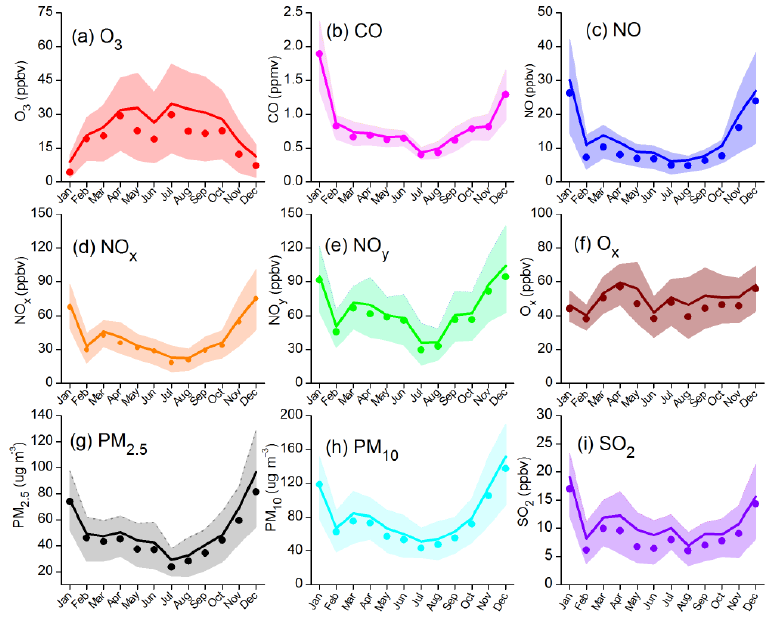
Figure 2. Seasonal variations of atmospheric O 3 (a) , CO (b) , NO (c) , NO x (d) , NO y (e) , O x (f) , PM 2 . 5 (g) , PM 10 (h) , and SO 2 (i) . Bold solid lines show the monthly averages, solid circles show the median values, and thin lines represent percentiles of 75 and